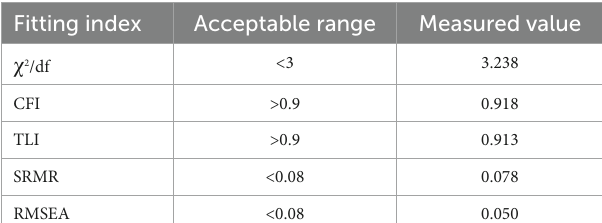
TABLE 3 Degree of model